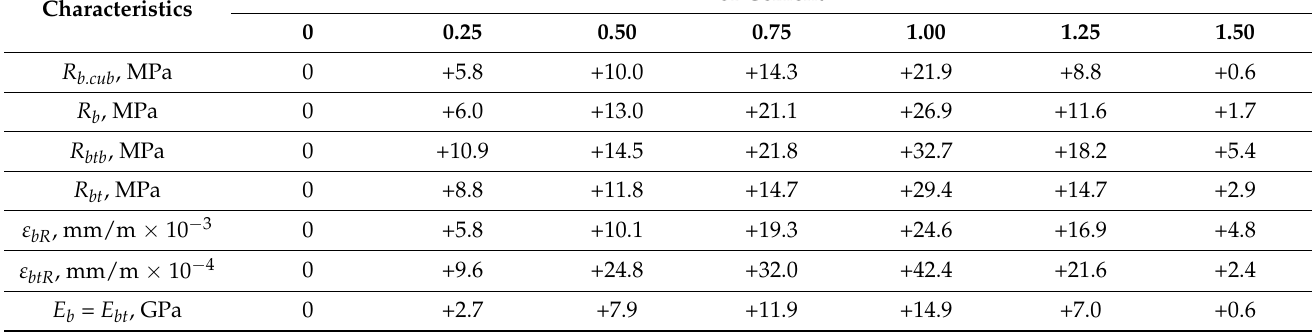
Table 4. Influence of the percentage of reinforcement with sisal fibers on the strength and deformation characteristics of samples from normal weight concrete.